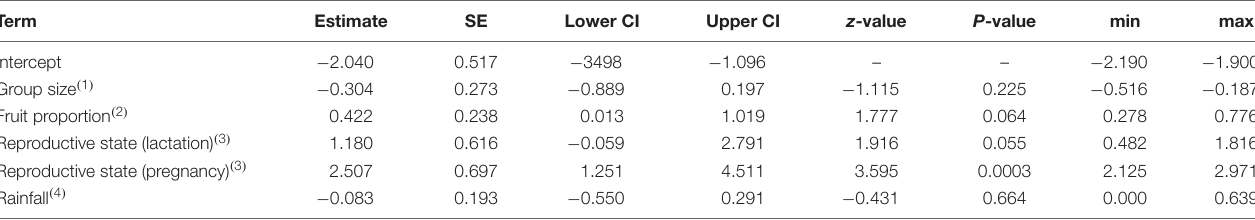
TABLE 2 | Results of the model of the effects of female reproductive state, fruit proportion in the diet, and group size on the probability to of singing: estimates, together with standard errors, confidence intervals, test results, and minimum and maximum of model estimates derived by dropping levels of random effects one at a time. Term Estimate SE Lower CI Upper CI z -value P -value min max Intercept − 2.040 –